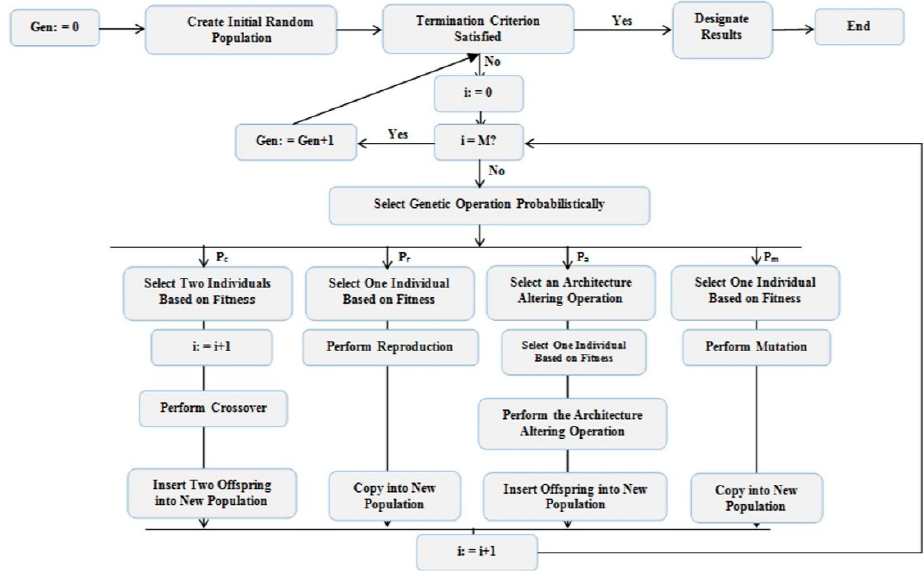
Figure 4. Typical genetic programming flowchart